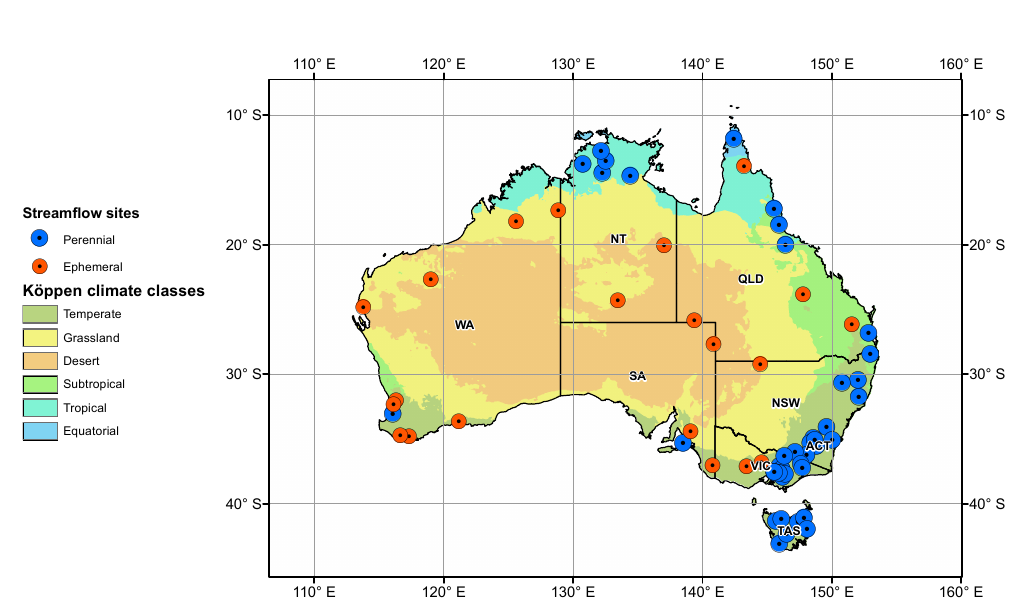
Figure A1. Distribution of gauge/inflow sites showing ephemeral/perennial